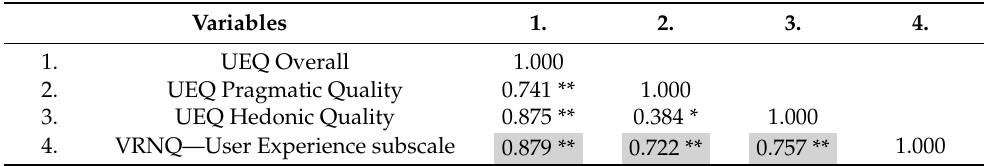
Table 17. Correlation matrix for HA_RFG condition—Spearman ( ρ ) correlation coefficients for combined user experience measures ( n = 4).